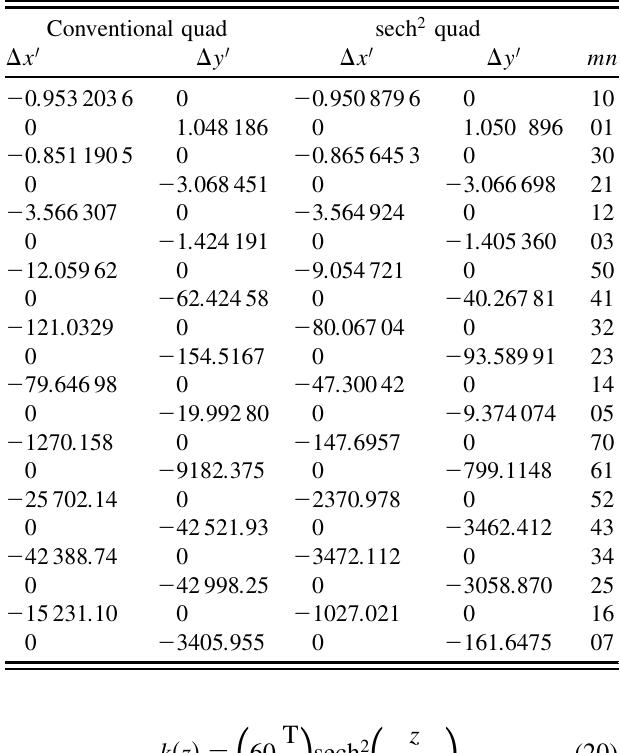
TABLE I. Aberration coefficients of a conventional quadru- pole, compared with quadrupole of sech 2 strength function, with same integrated strength. m and n are the exponents of x and y ; for example, the fourth line gives (cid:1) y 0 ¼ ð(cid:2) 3 : 07 m (cid:2) 3 Þ x 2 y for either quad.